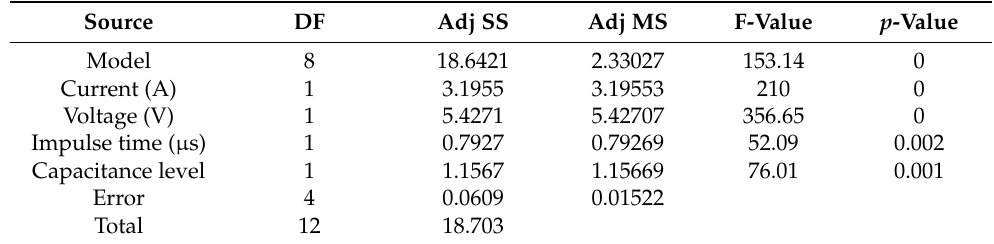
Table 6. Statistical analysis (ANOVA) of the influence of the machining parameters on the surface quality for 0–180 ◦ orientation.